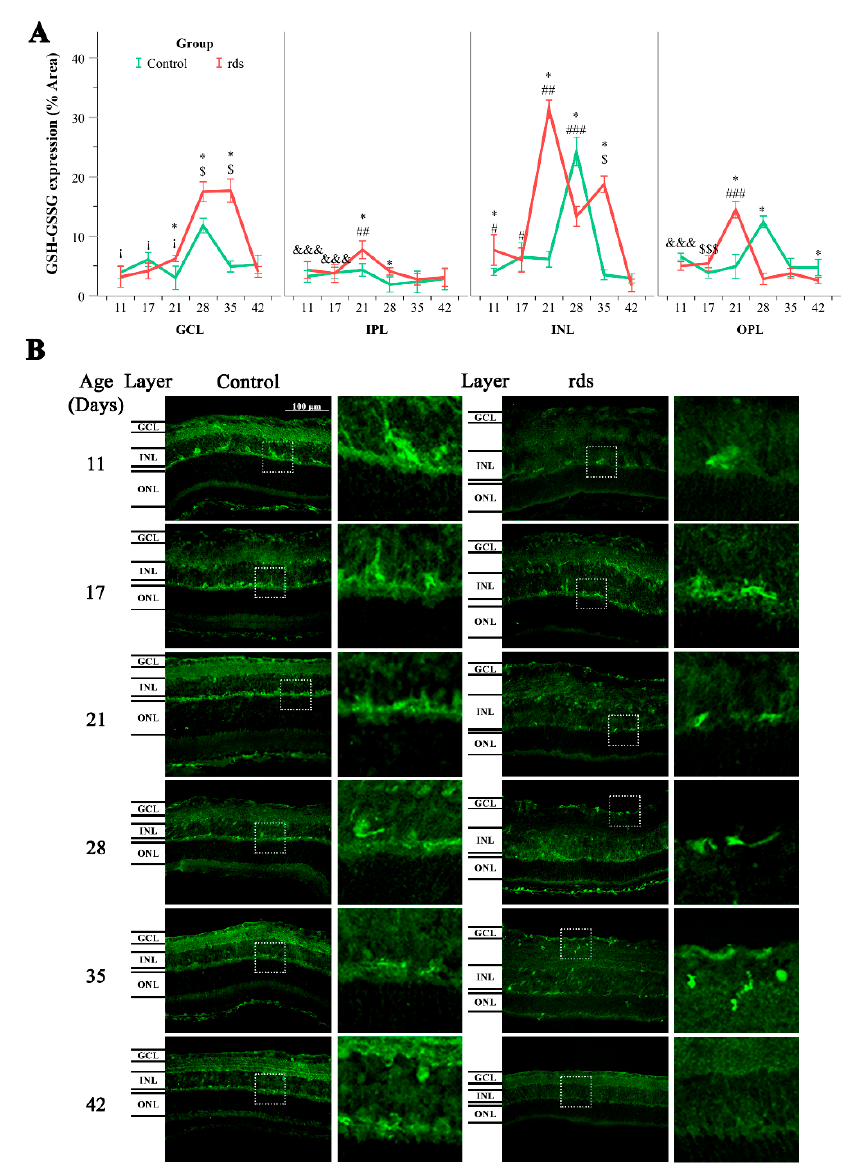
Figure 6. Glutathione expression in the control and rds retinas. ( A ) Glutathione expression (% of stained area) in GCL, IPL, INL, and OPL at different postnatal ages (* p < 0.05 vs. control group on the same postnatal day; # p < 0.05 vs. rds PN21, PN28, PN35, and PN42; ## p < 0.01 vs. rds PN28, PN35, and PN42; ### p < 0.0001 vs. rds PN35 and PN42; $ p < 0.0001 vs. rds PN42; $$$ p < 0.05 vs. rds PN28 and PN35; &&& p < 0.05 vs. rds PN21; ¡ p < 0.0001 vs. rds PN17). Four mice per group were used and three histological sections of one retina of each mouse were quantified. ( B ) Representative micrographs of retinal sections evaluated for glutathione in control and rds retinas at PN11, PN17, PN21, PN28, PN35, and PN42 (microscope 40× magnification photos).